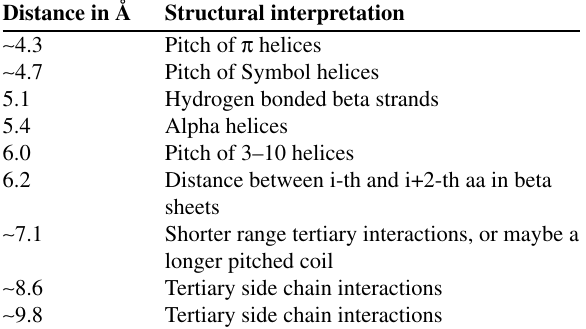
Table 1. A list of typical peaks. Prefix ∼ means that the exact di- stance of the peak may vary slightly from pair to pair. Distance in Å Structural interpretation ∼